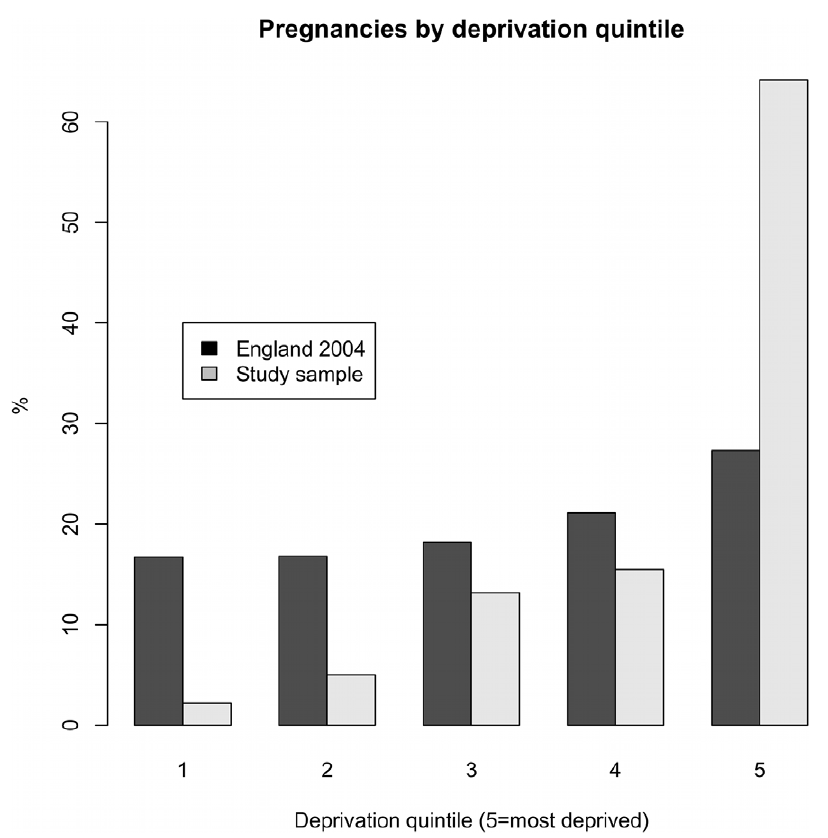
Figure 1. Pregnancies by deprivation quintile for LWH study sample 2002–2008 and all pregnancies in England 2004. doi:10.1371/journal.pone.0023163.g001 16.7% for England as a whole. The distribution of deprivation scores were similar in both the high (median= 46.4 and mean = 44.4) and low risk groups (median =47.4 and mean = 45.1).